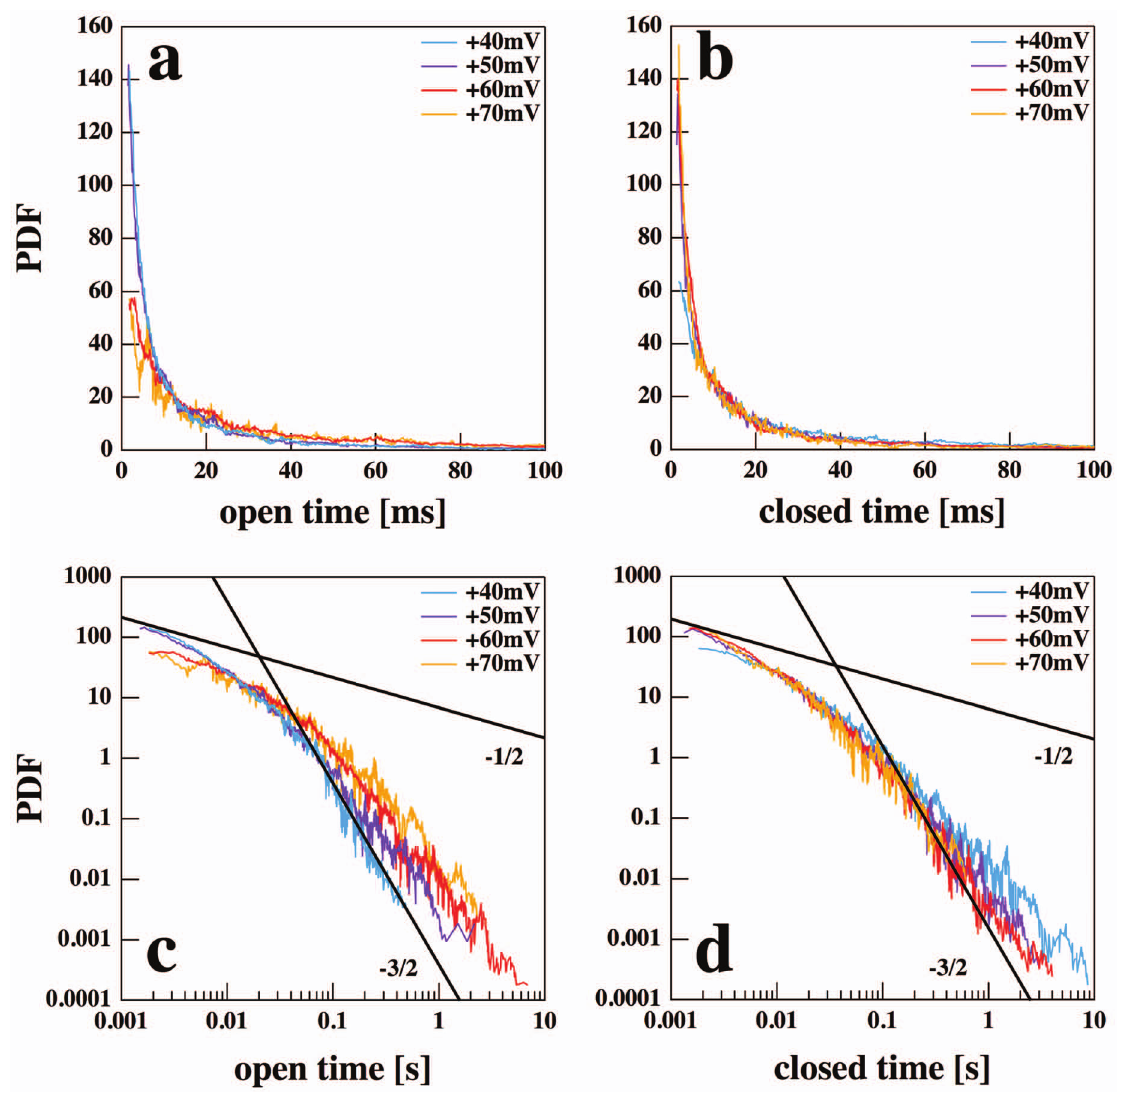
Figure 7. Open and closed lifetimes of the lipid ion channels for the traces at four different voltages shown in Fig. 4. (A) Probability distribution functions (PDF) of the channel open-times at short times of up to 100 ms. (B) Closed time PDF. (C) and (D). Double-logarithmic representation of panels A and B over time scales up to 10 seconds. One can recognize that the PDFs are non-exponential, but also do not obey a simple power law in the double-log plot. The solid lines are guides to the eye with slopes of 2 1/2 and 2 3/2. At long times the pdf seem to approach a t { 3 = 2